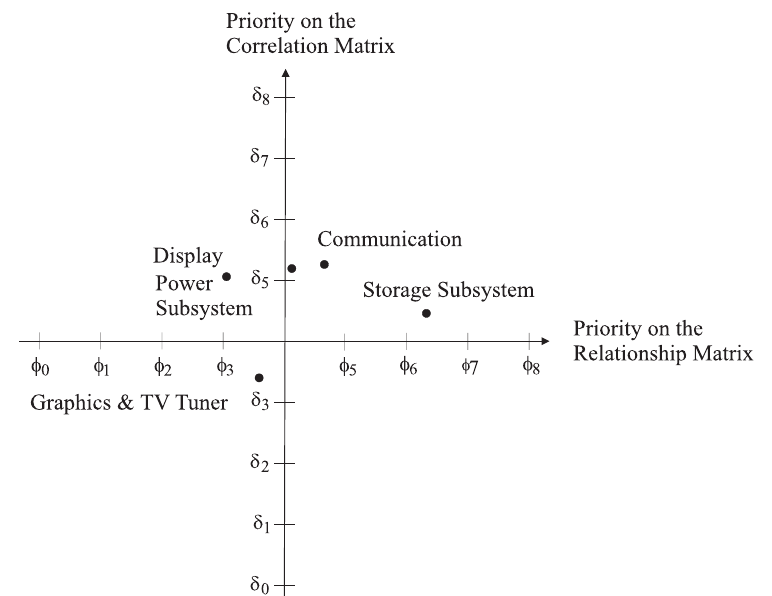
Fig. 8. Synergistic analysis for the relationship and correlation